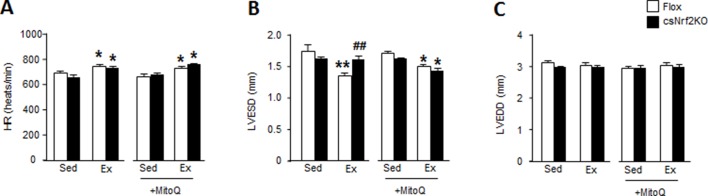
Mitochondrial-targeted antioxidant MitoQ improves cardiac response to exercise in csNrf2KO.Cardiac function was evaluated by conscious echocardiography prior to (sedentary, Sed) and after exercise (Ex) with or without MitoQ treatment. Mean data for heart rate (HR), left ventricular end-systolic dimension (LVESD) and left ventricular end-diastolic dimension (LVEDD) (A to C). *p<0.05, **p<0.01 vs respective sedentary controls, ##p<0.01 vs Flox/Ex, 2-way ANOVA followed by Tukey post hoc analysis (N = 6–7/group).